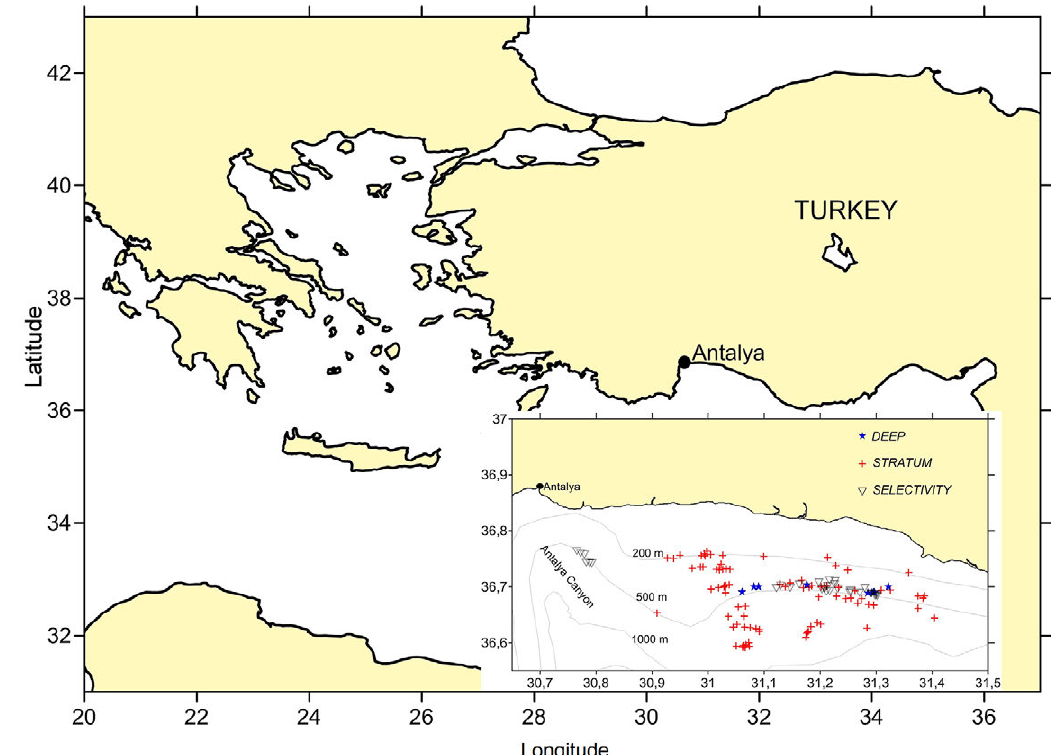
Fig. 1. – Bathymetry map of the study area in Antalya Bay. The positions of the hauls realized from 200 to 990 depth for three